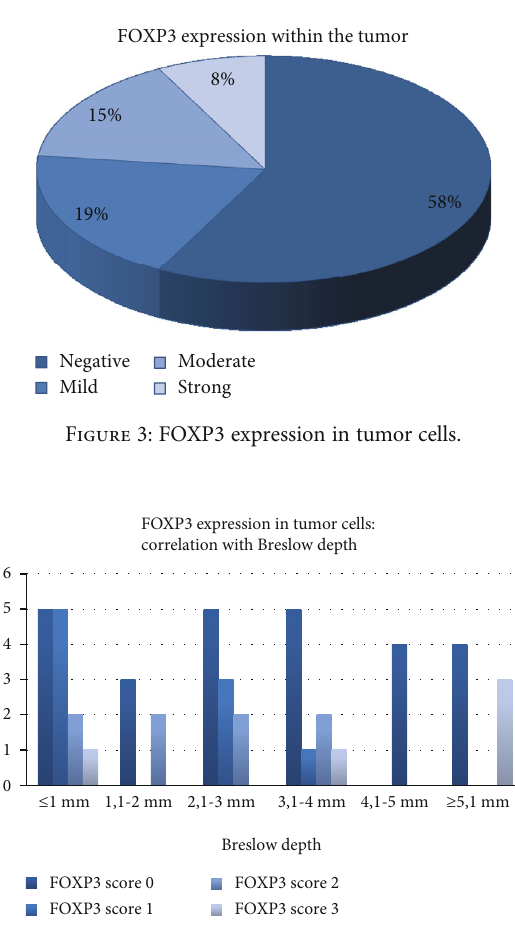
Figure 4: FOXP3 expression within the tumor — correlation with the Breslow depth.